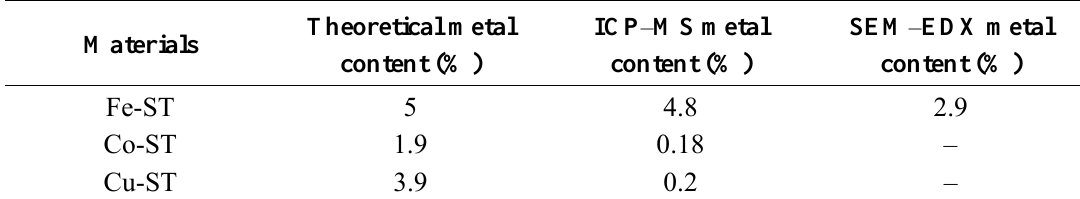
Table 2. Actual metal content in mesoporous starches as compared to the theoretical content obtained by ICP–MS and